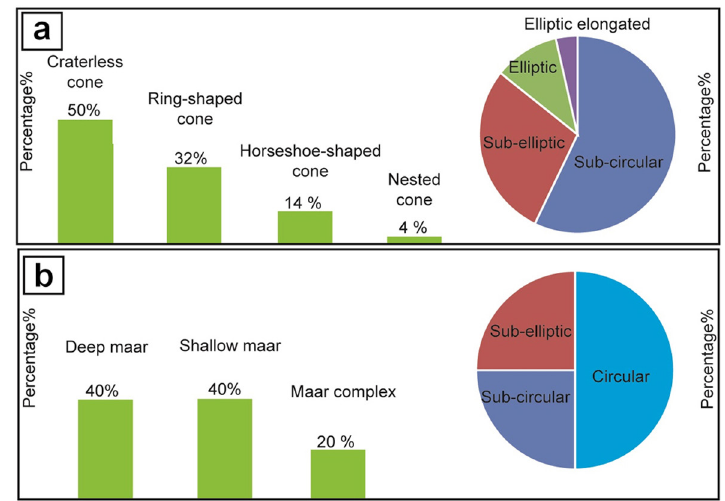
Fig. 10. Morphological classification of cones (a) and maars